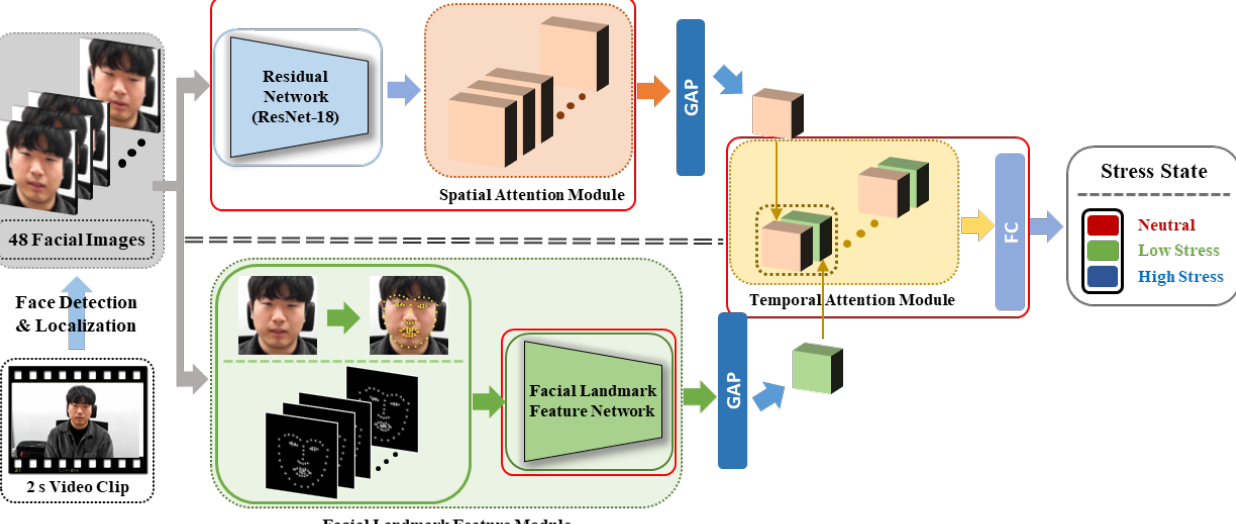
Figure 2. Flowchart of the proposed method. The residual network ResNet-18 extracts feature maps from facial images. GAP: global average pooling; FC: fully connected